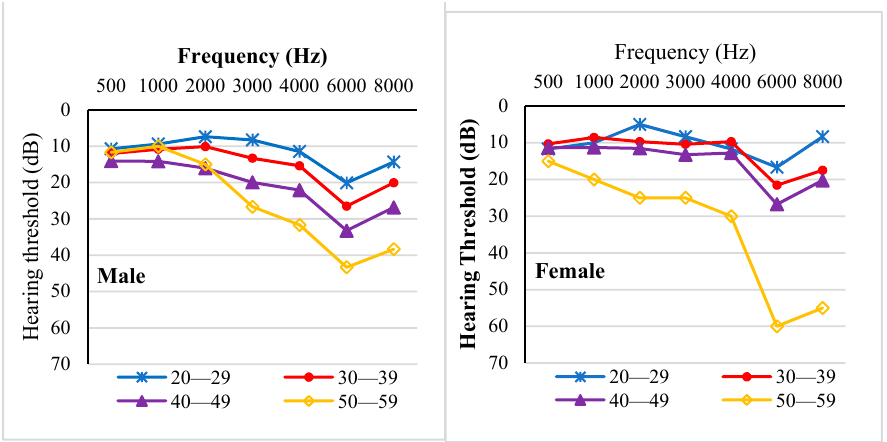
Figure 4. Visualized comparison of the average HTs between noise-exposed male workers ( left panel ) and female workers ( right panel ) by frequency and age group.